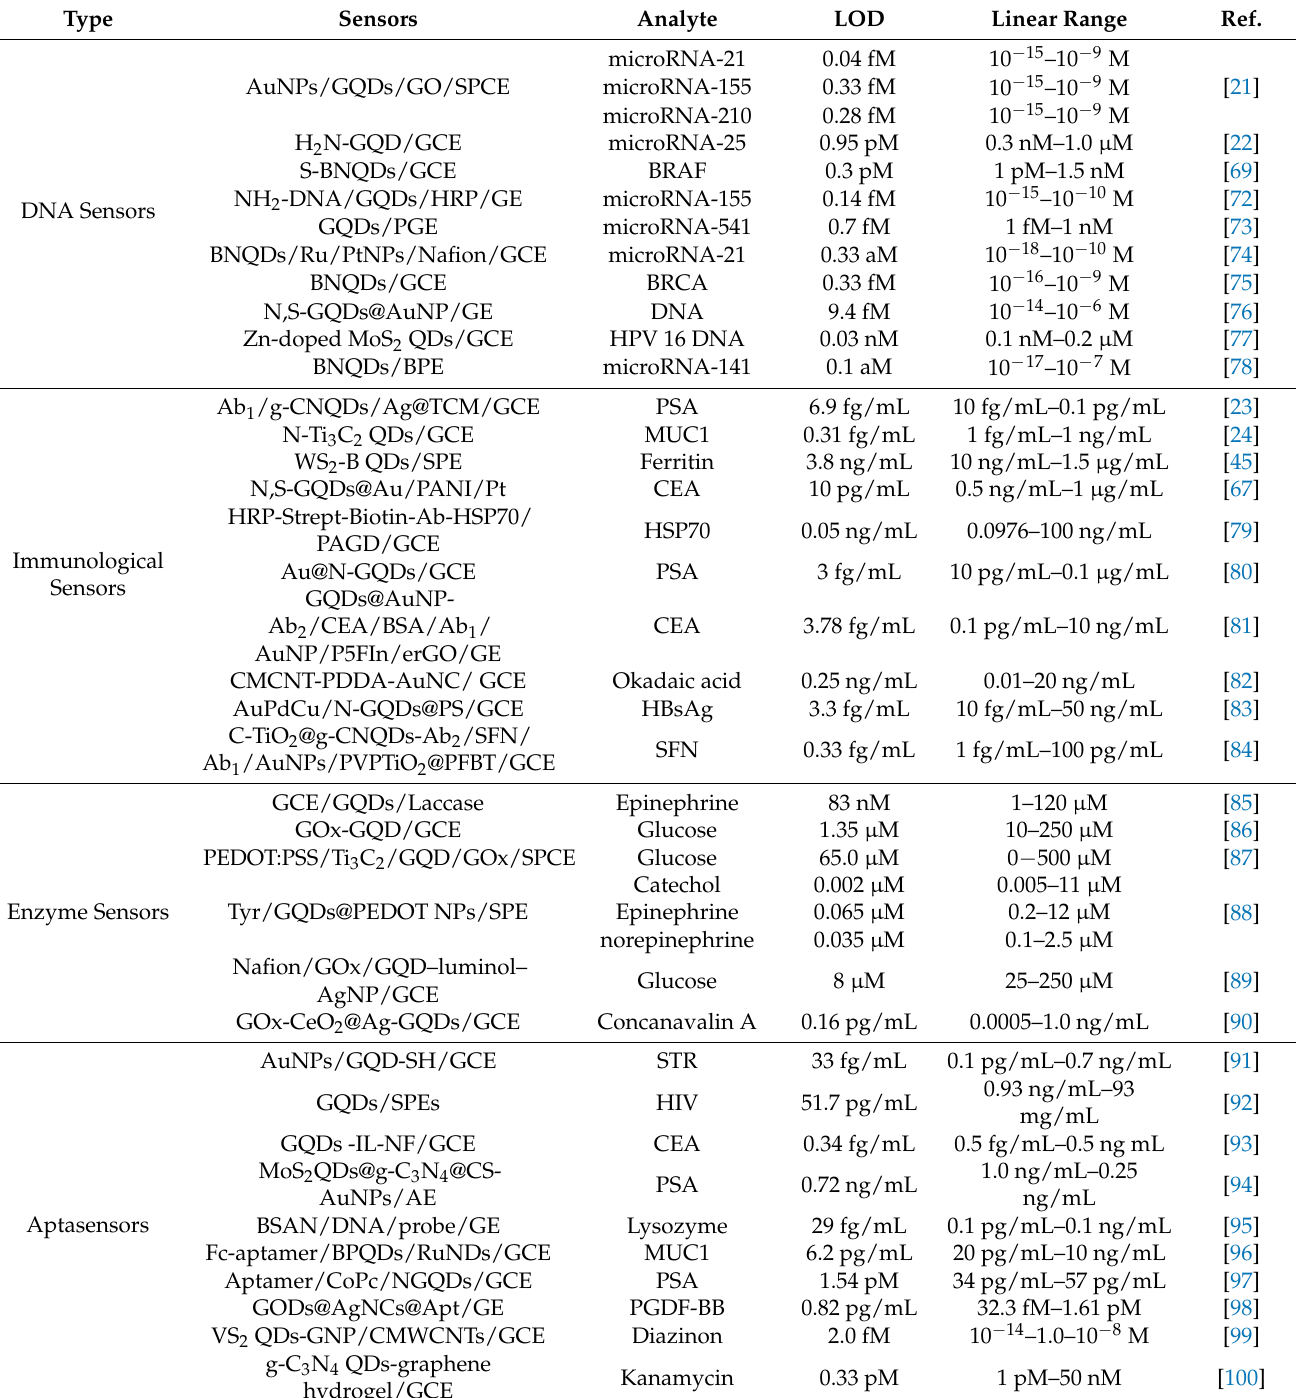
Table 3. Applications of 2D-QDs in electrochemical